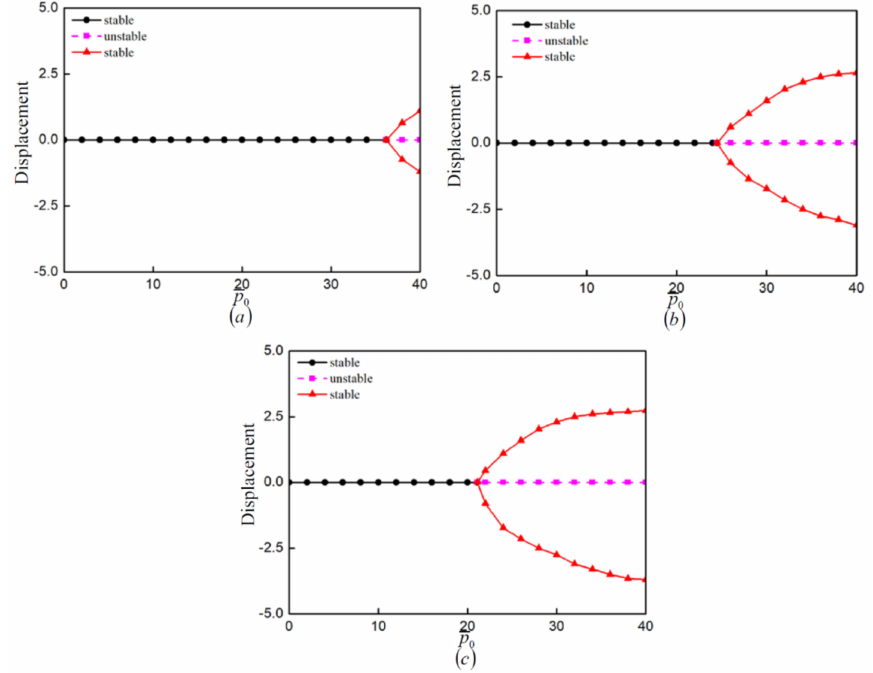
Figure 7. The transverse deflection of the CFRP laminated cylindrical shell versus the static in-plane load with different ratios of length to thickness L / h : ( a ) L / h = 80, ( b ) L / h = 100, ( c ) L / h = 120.